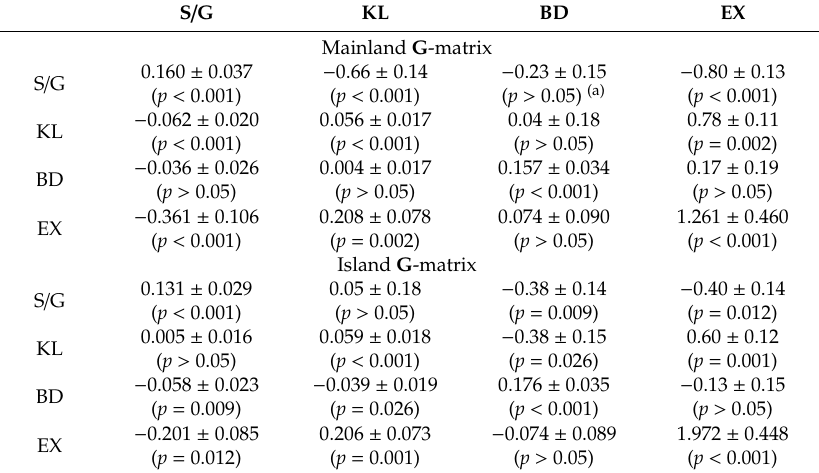
Table 3. Additive genetic ( G ) variance-covariance matrices estimated for wood traits (S / G, KL, BD, and EX) within the Mainland and Island population groups of E. globulus . Parameter estimates are given together with their standard errors for variances (diagonal), covariances (below diagonal), and correlations (above diagonal). S / G KL BD EX Mainland G -matrix